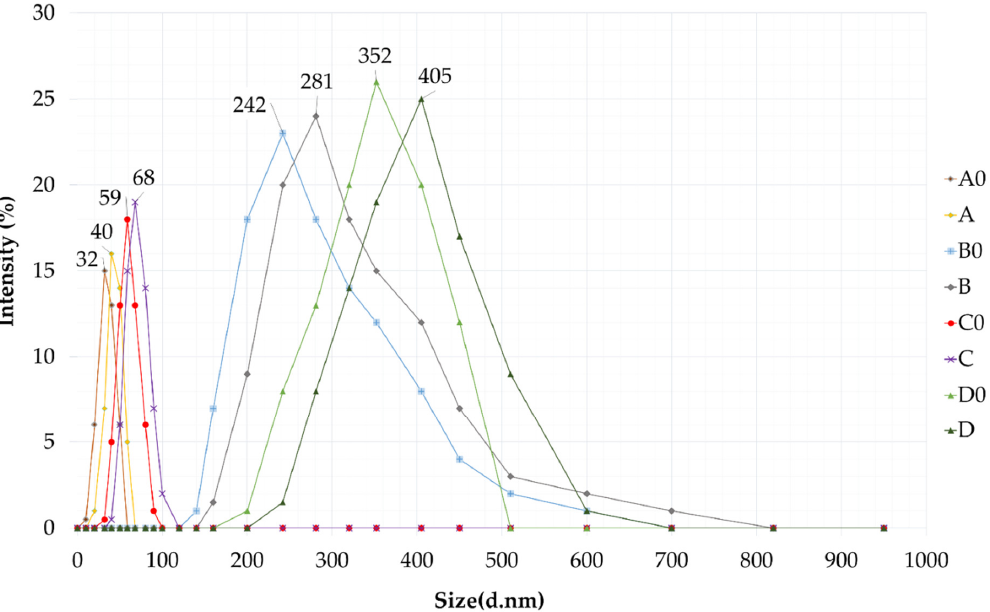
Figure 4. Droplet size of self-nano- and microemulsifying drug delivery systems (SNEDDS and SMEDDS) in water via dynamic light scattering (DLS) measurement.